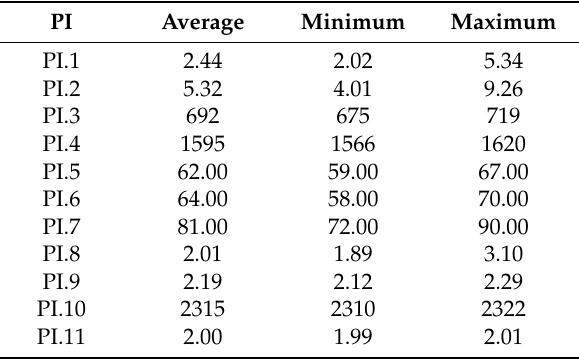
Table 5. Average, minimum and maximum values of Scenario A.